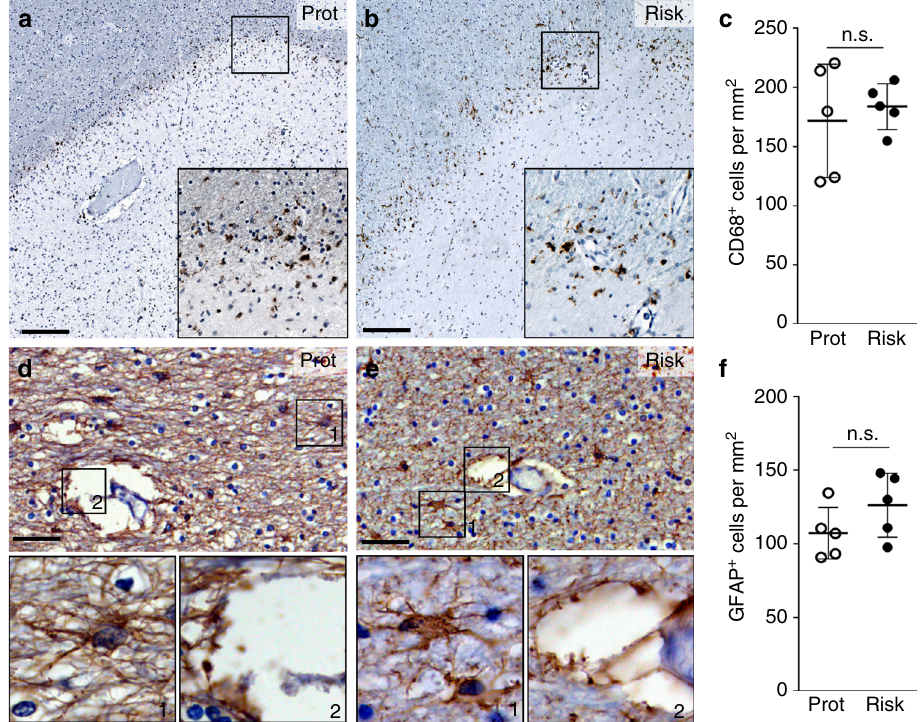
Fig. 3 Glial density in MS lesions with the rs7665090 risk and protective genotypes. a , b Staining for CD68 (brown) shows activated microglia at the lesion rim of chronic active lesions, counterstained with hematoxylin (blue). Magni fi cations in the inset. c Quanti fi cation of CD68 + cell densities in the rim of 29 lesions (15 risk group, 14 protective group) from 10 MS cases ( fi ve cases per group) shows no signi fi cant difference between groups. The number of lesions from each case ranged from 1 to 5. d , e Staining for GFAP (brown) shows hypertrophic astrocyte morphology (inset 1) and partially disrupted astrocytic glia limitans (inset 2) at the lesion rim. f Quanti fi cation of GFAP + cell densities in 10 lesions from 10 MS cases ( fi ve cases per group) shows no signi fi cant difference between groups. Dots represent average cell densities for all lesions per case. Data represent means ± s.d. Signi fi cance was determined with unpaired t -test. Scale bars = 100 µ